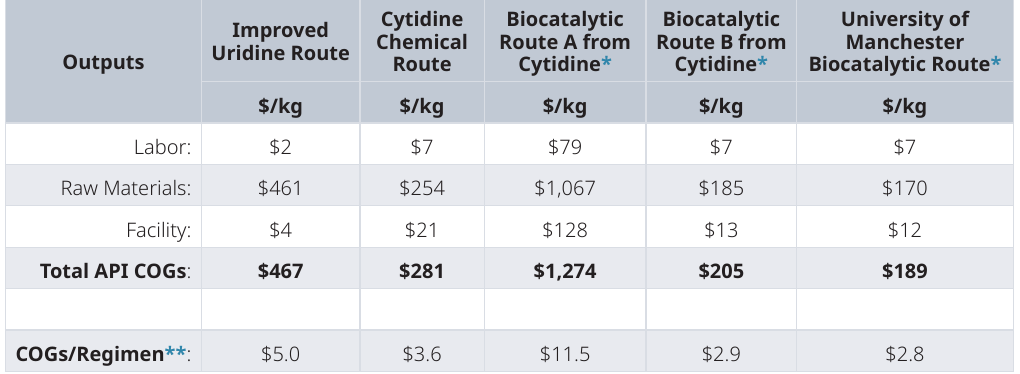
Table 2. API and Regimen COGs outputs and associated costs of synthetic routes of molnupiravir manufacture.